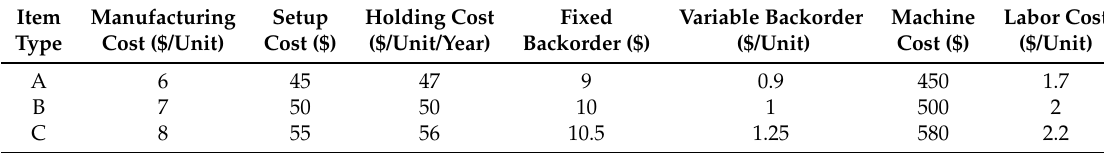
Table 2. Data related to the production costs.